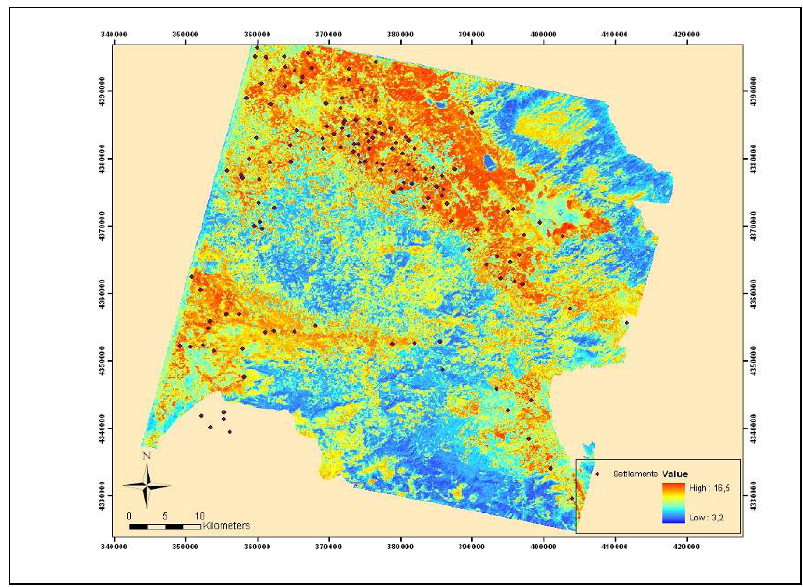
Figure 18. Map of predictive